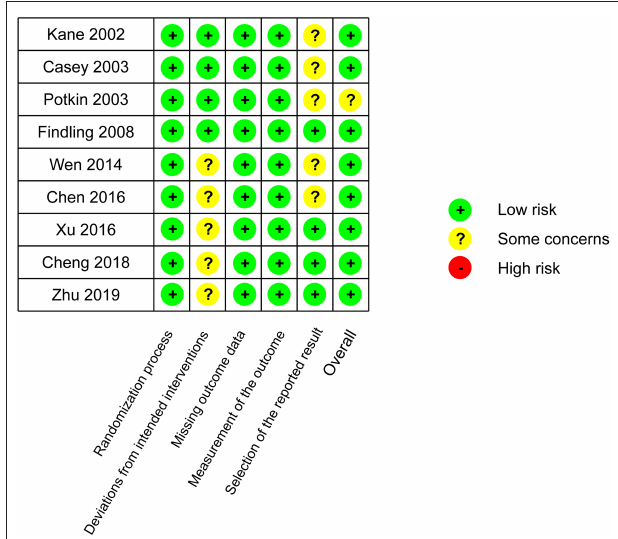
FIGURE 6 | Risk-of-bias assessment.